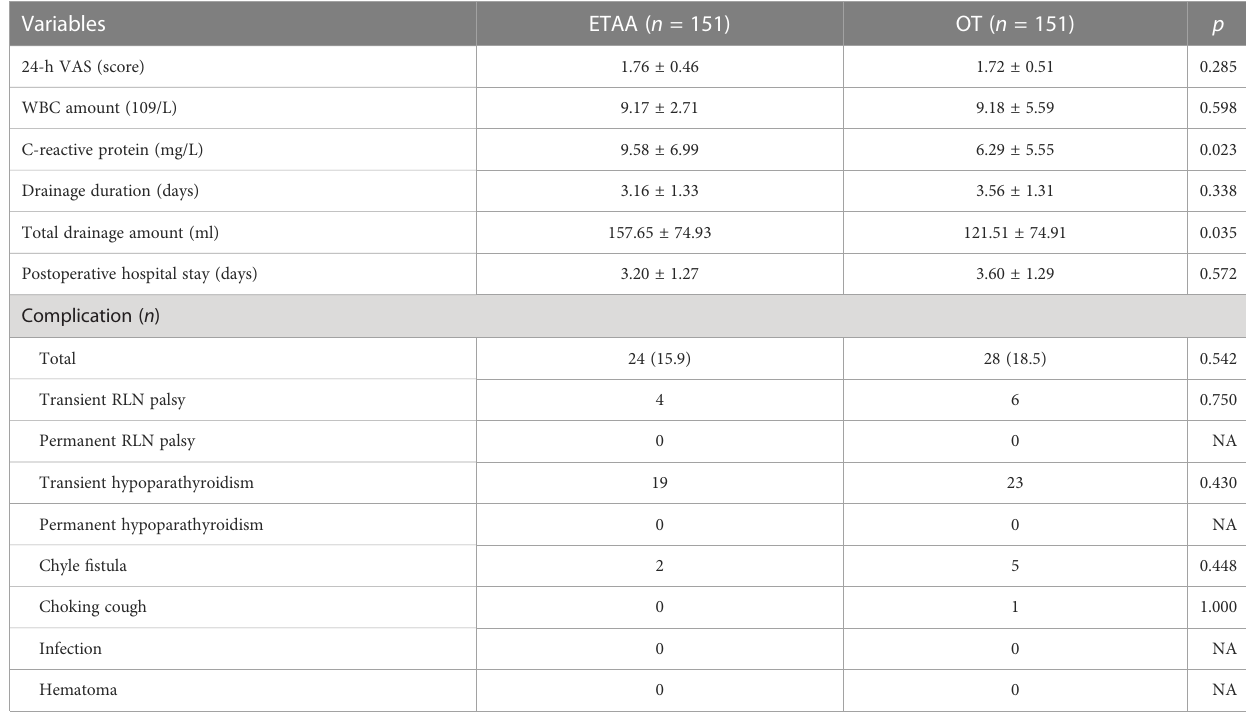
TABLE 3 Postoperative outcomes.